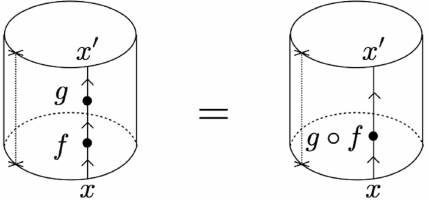
Figure 4 . The transition amplitude Z ( g ◦ f ) corresponding to the composition of topological point operators agrees with the composition Z ( g ) ◦ Z ( f ) of the transition amplitudes corresponding to each topological point operator. This is because putting a topological point operator g ◦ f can be regarded as putting two topological point operators f and g